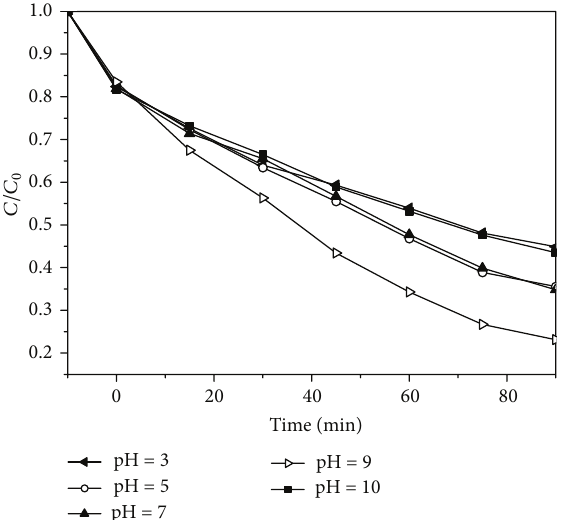
Figure 9: Comparison of Bisphenol A degradation by commercial P25, 75% BiOI + TiO 2 , and synthesized BiOI-TiO 2